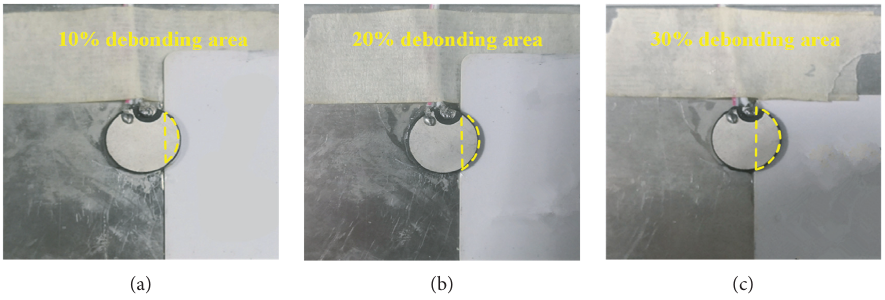
Figure 5: Debonding of 2# PZT. (a) 10% debonding; (b) 20% debonding; (c) 30% debonding.